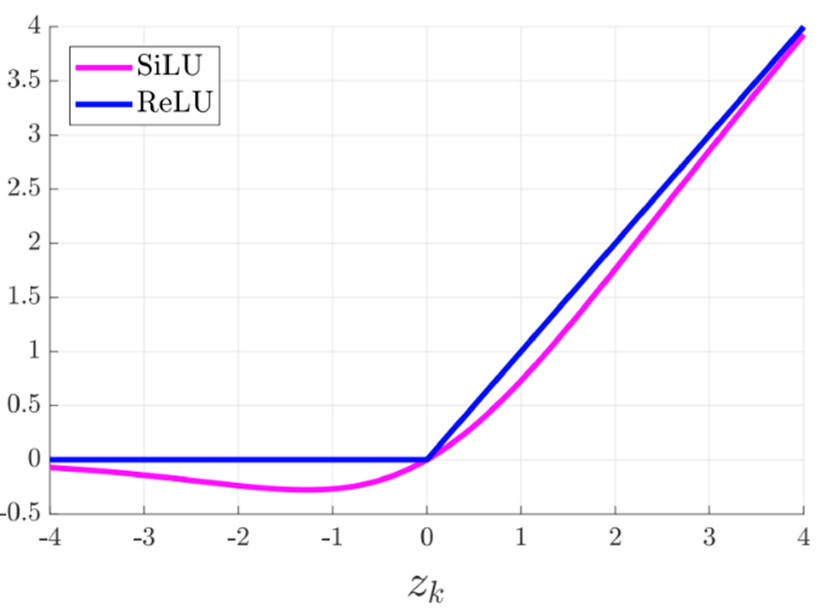
Figure 5. SiLU [43] and ReLU [38] activation function. The learning rate was initialized from 0.0003 and increased up to 0.16 in 500 steps. The computer system comprised an Intel(R) Gold 5218 (2X) CPU with DDR4 2666 MHz ECC RDIMM 64 GB*8 RAM, and NVIDIA GeForce RTX 3090 GPU 24 GB*2. The batch size was set at 128. Mixed FP16 and FP32 precisions were adopted for training, the mixed parameters were set to NVIDIA Apex AMP O3, and the training time was around 4 days and 12